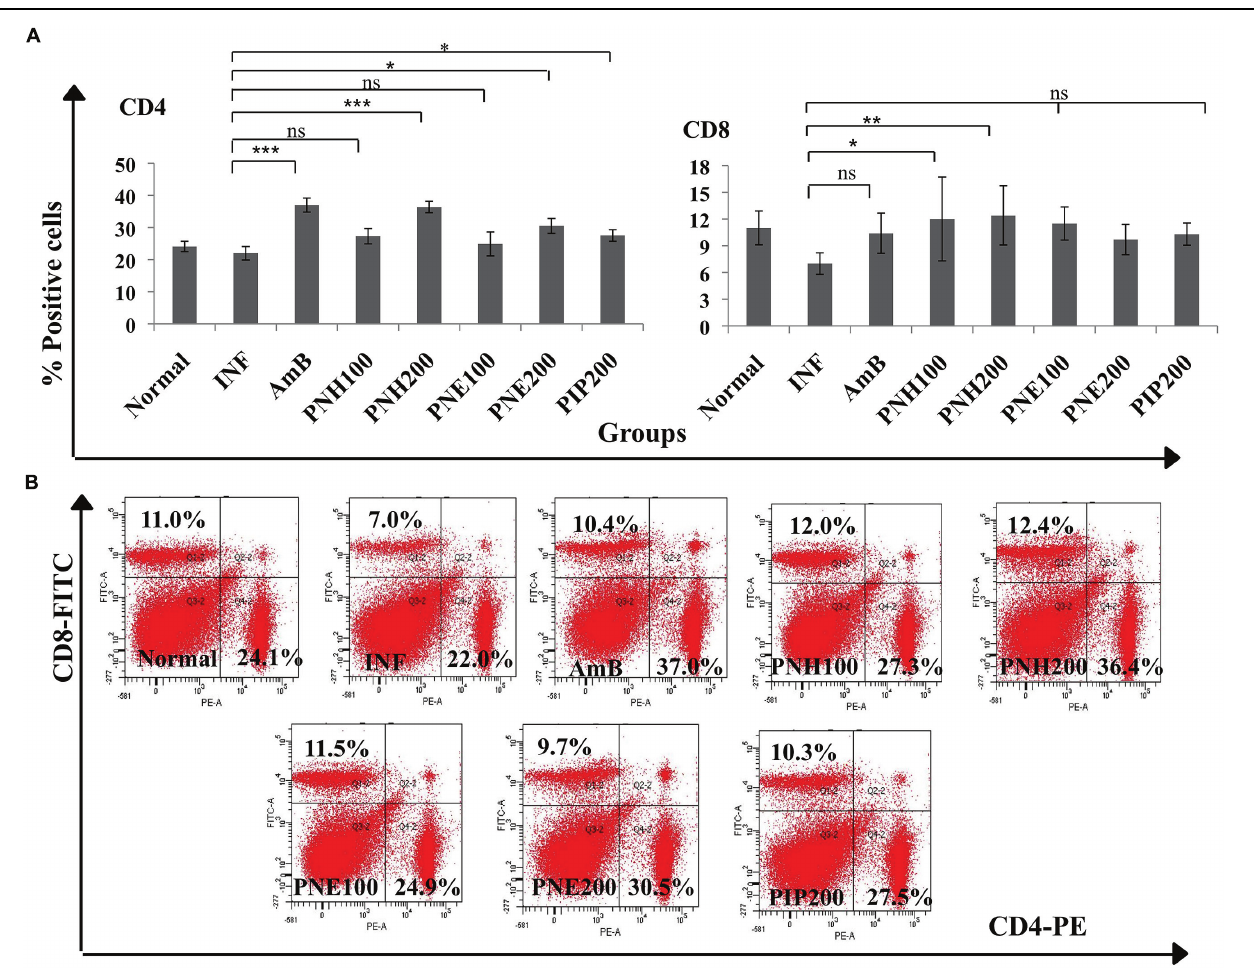
FIGURE 7 | Determination of changes in splenic T cell populations. (A) To distinguish CD4 + and CD8 + T cell population, co-staining with anti-CD4-PE and anti-CD8-FITC antibodies was performed as described in the Section “Materials and Methods”. Bar graphs display significant and non-significant changes in CD4 + and CD8 + T cell numbers post-treatment with bioactive fractions. ∗∗∗ P < 0.001, ∗∗ P < 0.01, ∗ P < 0.05, and ns = non-significant with respect to INF. (B) Dot plots also depicting the changes in splenic CD4 + and CD8 + T cell numbers after treatment with P. nigrum bioactive